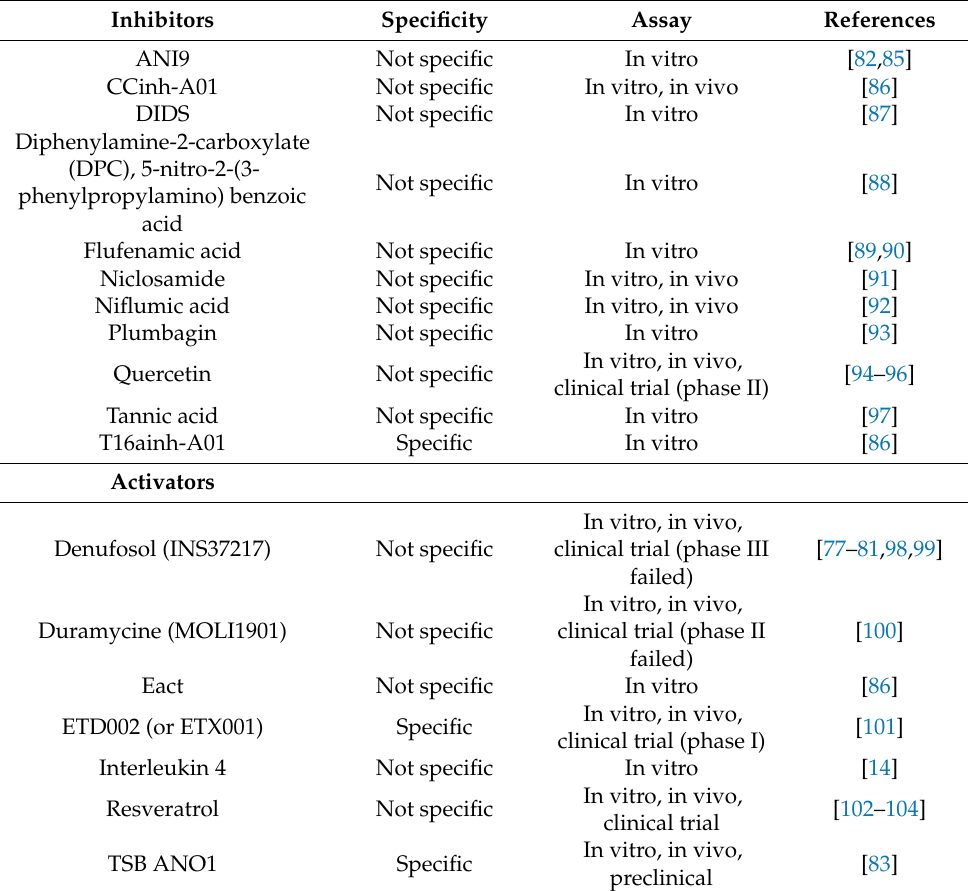
Table 1. Summary of ANO1 inhibitors and activators used in